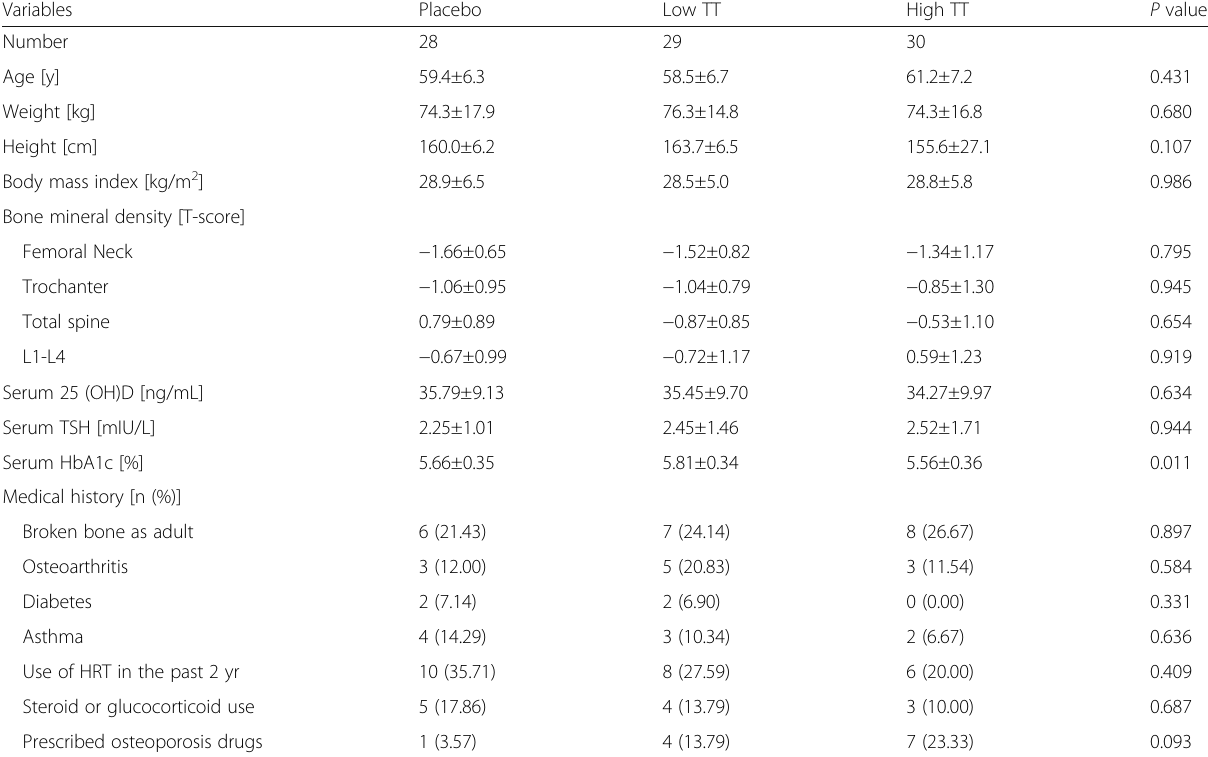
Table 1 Baseline demographic characteristics of study population Variables